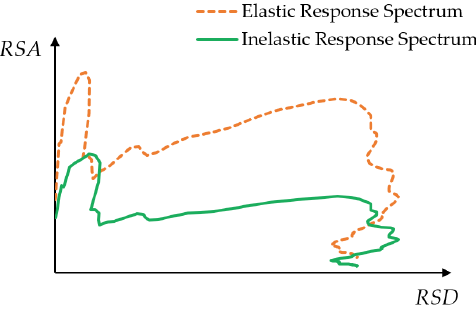
Figure 4. Illustration of the inelastic site-specific response spectrum.